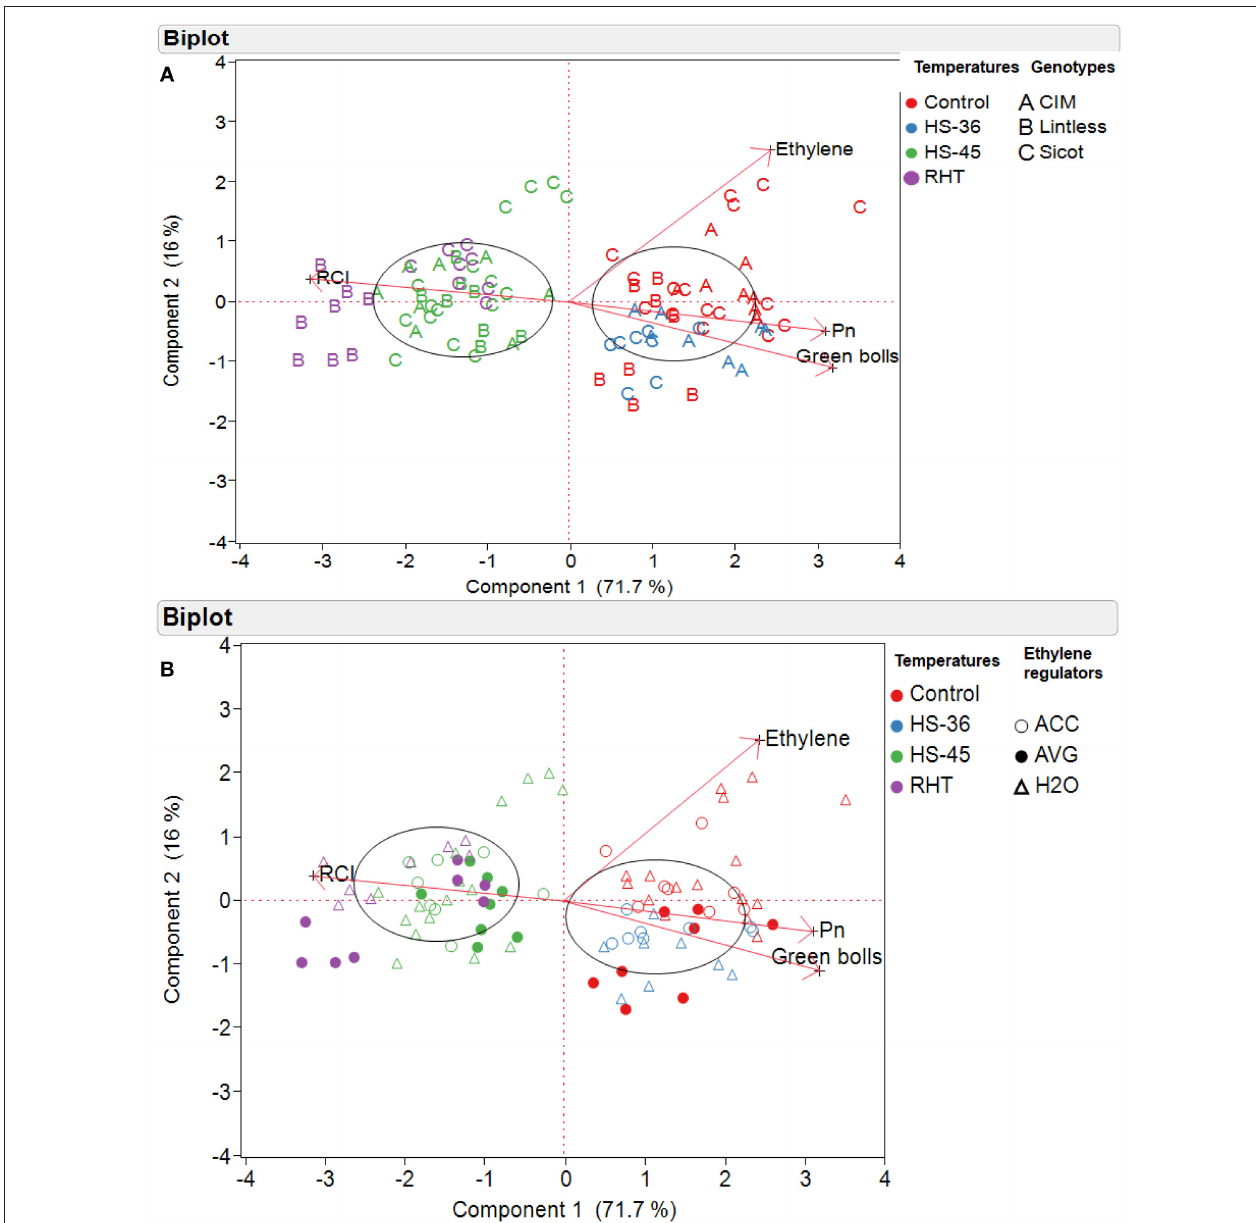
FIGURE 7 | Principal component analysis (PCA) of cotton plants subjected to different temperatures, based on (A) cotton genotypes and (B) ethylene regulators. The temperature treatments were control (28), heat shock to 36 ◦ C (HS-36), heat shock to 45 ◦ C (HS-45) and ramping high temperature to 45 ◦ C (RHT). Ethylene regulators, including 1-aminocyclopropane-1-carboxylic acid (ACC), aminoethoxyvinylglycine (AVG) and water (H 2 O) were sprayed 1 day prior to heat treatment. A biplot shows two-dimensional loadings of various variables e.g., Ethylene (concentration youngest fully expanded leaves), P n (rate of photosynthesis in youngest fully expanded leaves), number of green bolls (per plant), and RCI (%, relative cell